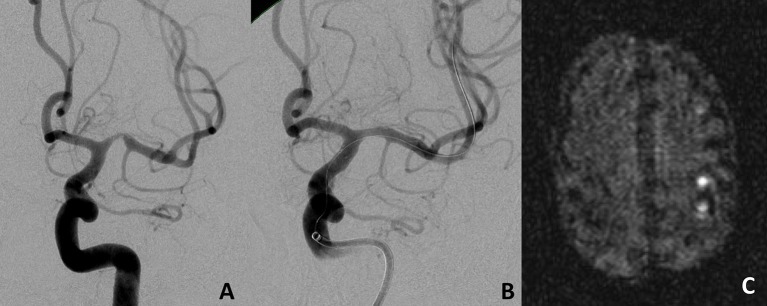
Proximal left middle cerebral artery M1 stenosis before (A) and after (B) Stent-PTA treatment. MRI at day 1 after the procedure showed asymptomatic cortical embolic infarctions in the left middle cerebral artery territory (C).